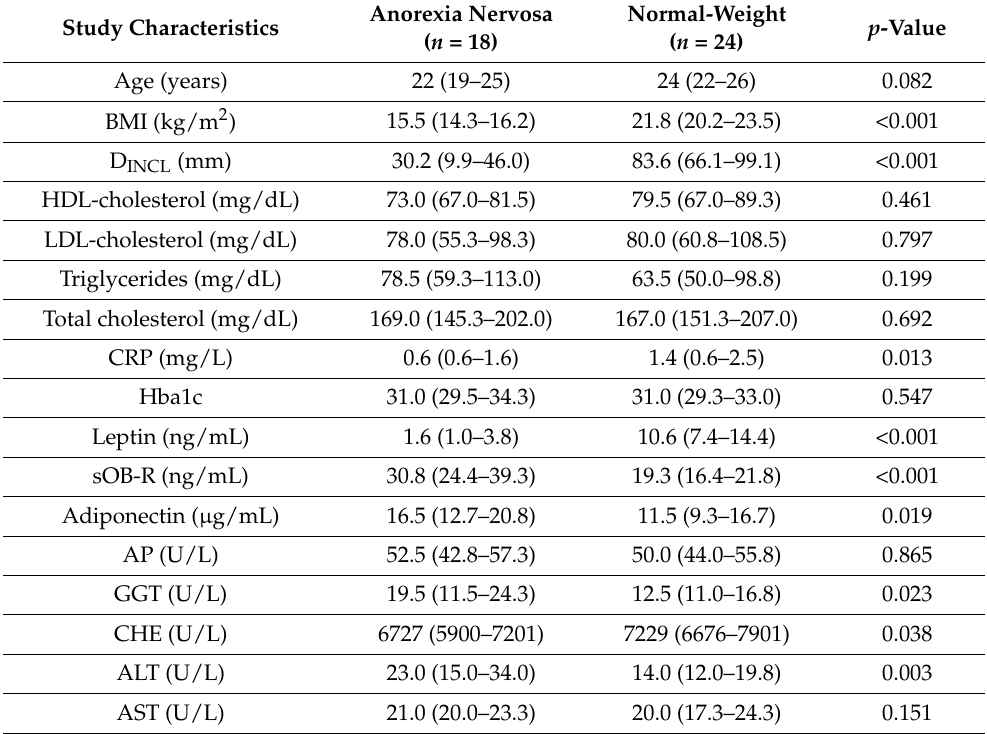
Table 1. Clinical characteristics of the study